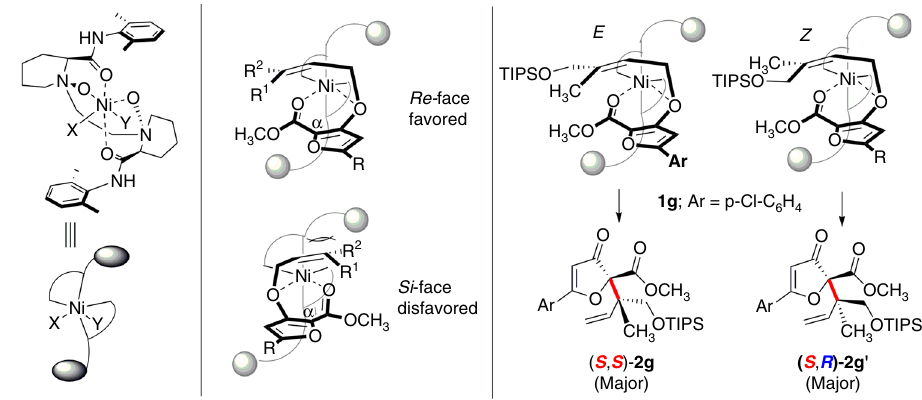
Fig. 6 Proposed stereochemical model. Substrate 1g was selected for the model